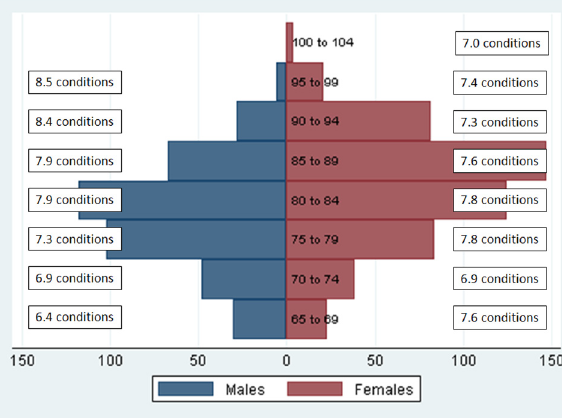
Fig 1. Mean number of conditions by sex and age group.